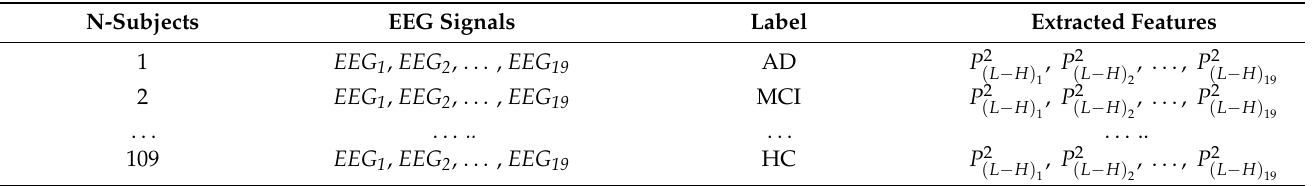
Table 1. Schema of the feature extraction procedure: features extracted from an EEG recording are shown in the last column.